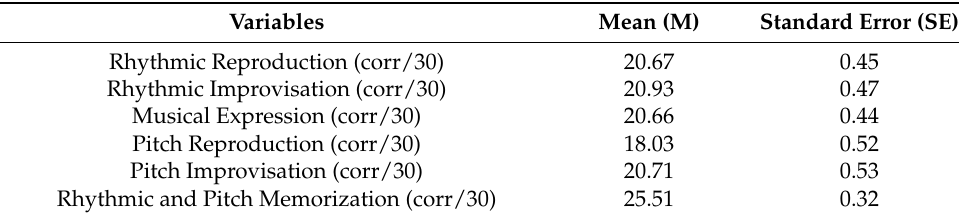
Figure 1. Specific criteria and measurements of the Musical Performance Assessment Scale (MuPAS). Table 2. Descriptive statistics of the six variables of the Musical Performance Assessment